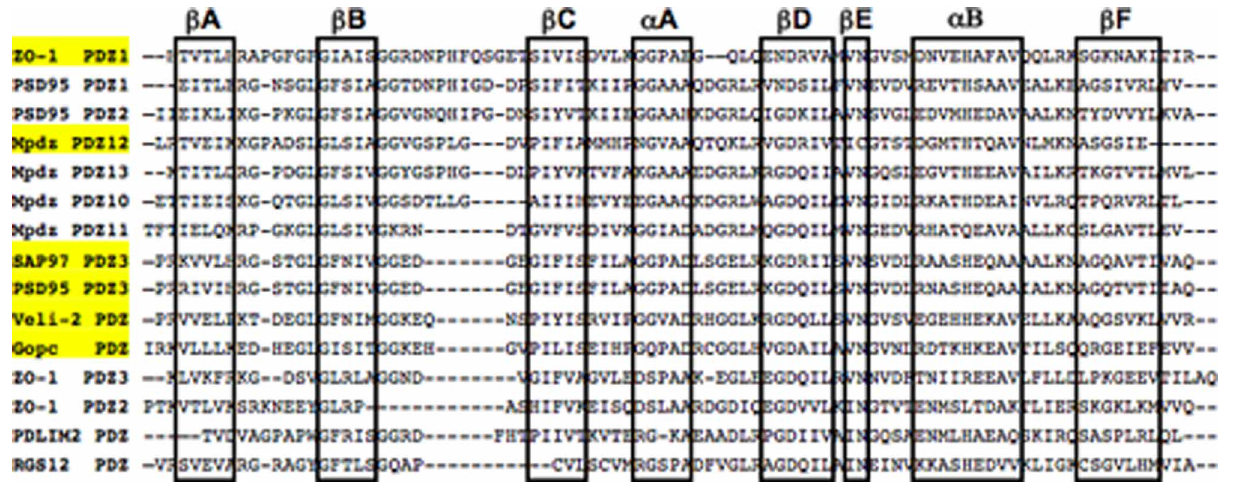
FIGURE A3 | PDZ domains sequence alignment. The amino acid sequence of select PDZ domains from GOPC, MPDZ, PDLIM2, PSD95, RGS12, SAP97, and Veli-2 used in our initial yeast-two hybrid screening were aligned using clustalW 2.1. Residues involved in α -helices and β -sheet structures are boxed.